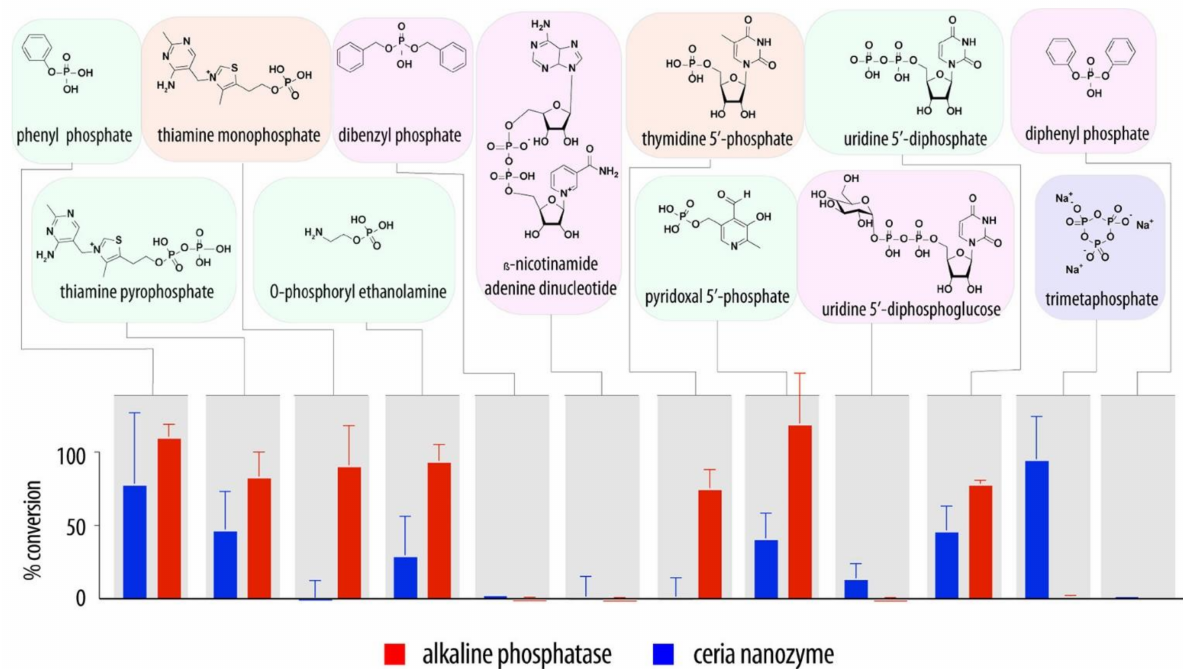
Figure 9. Substrate scope of ceria nanozyme, in comparison with alkaline phosphatase, for the hydrolysis of organic phosphates in a study for the delivery of phosphate prodrugs. Reproduced with permission from [91], Copyright © 2021, American Chemical